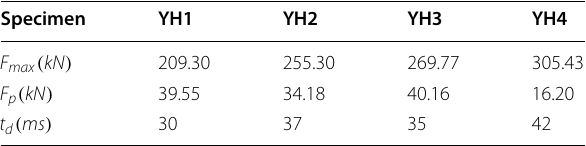
Table 4 Impact force data of